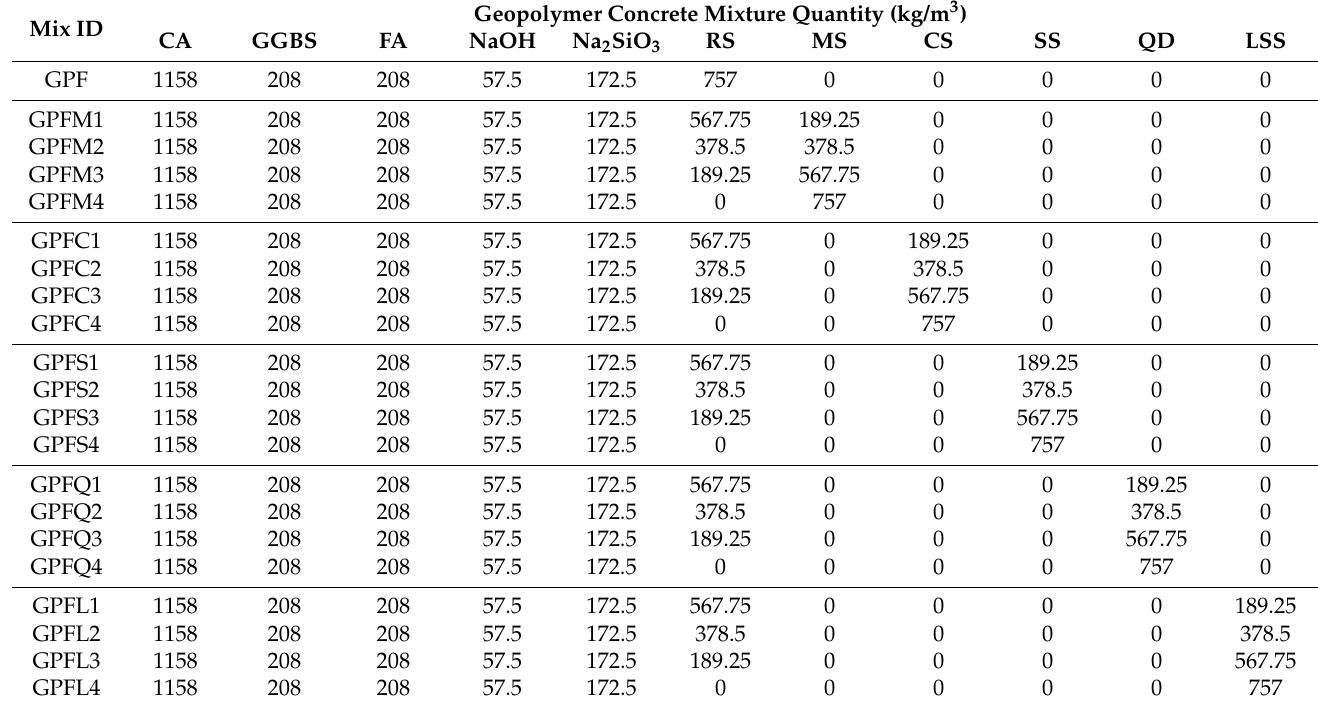
Table 4. Mix proportions for M 40 geopolymer concrete with various soil